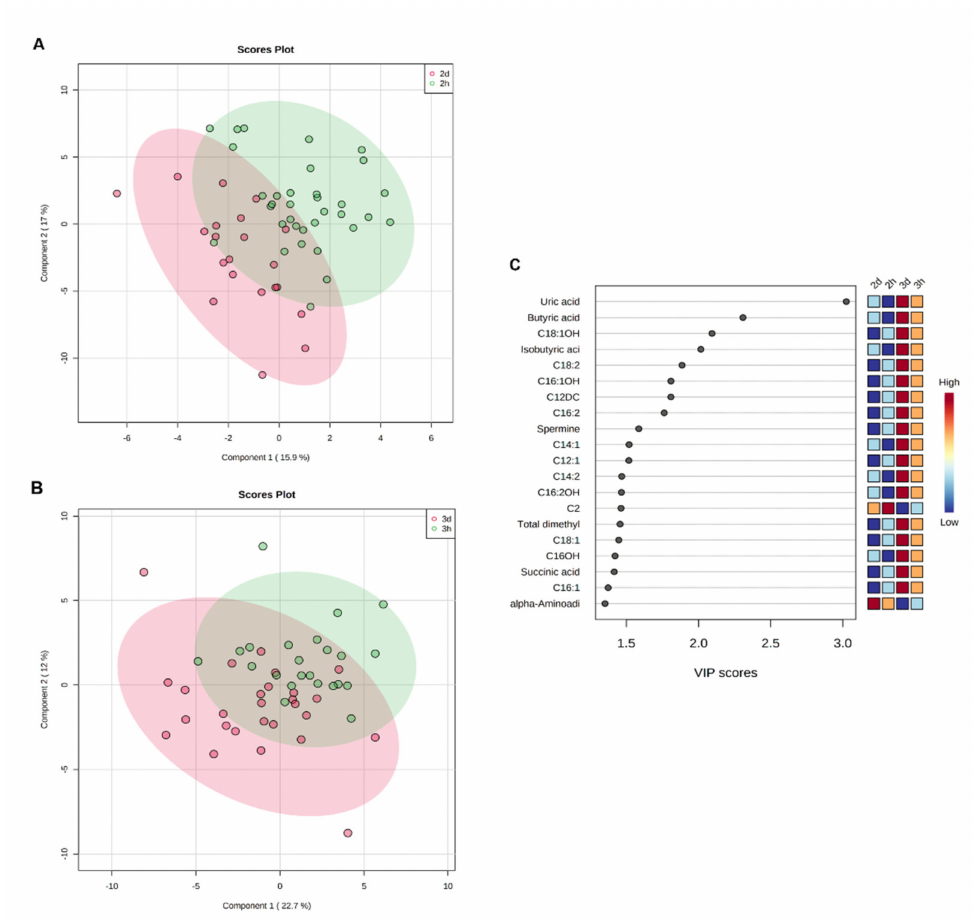
Figure 3. Multivariate analysis showing the comparison between urinary metabolite data acquired for GDM and healthy mothers in the second and third trimesters, respectively. ( A ) Partial least squares discriminant analysis score plots (2-D PLS-DA) of healthy pregnant women with GDM during the second trimester of gestation. ( B ) 2-D PLS-DA of healthy pregnant women with GDM during the third trimester of gestation. ( C ) Importance of the variable in the projection graph. The most discriminating metabolites are shown in descending order of their coefficient scores. Second trimester of gestation with GDM (2 d); third trimester of gestation with GDM (3 d); healthy second trimester of pregnancy (2 h); healthy third trimester of pregnancy (3